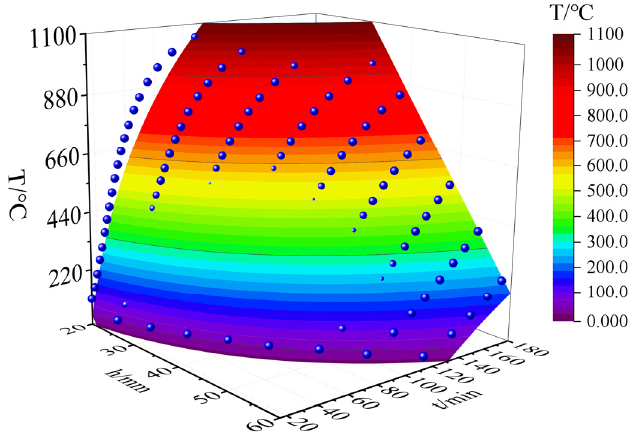
Figure 26. Surface fitting results of ceramic fiber felt.